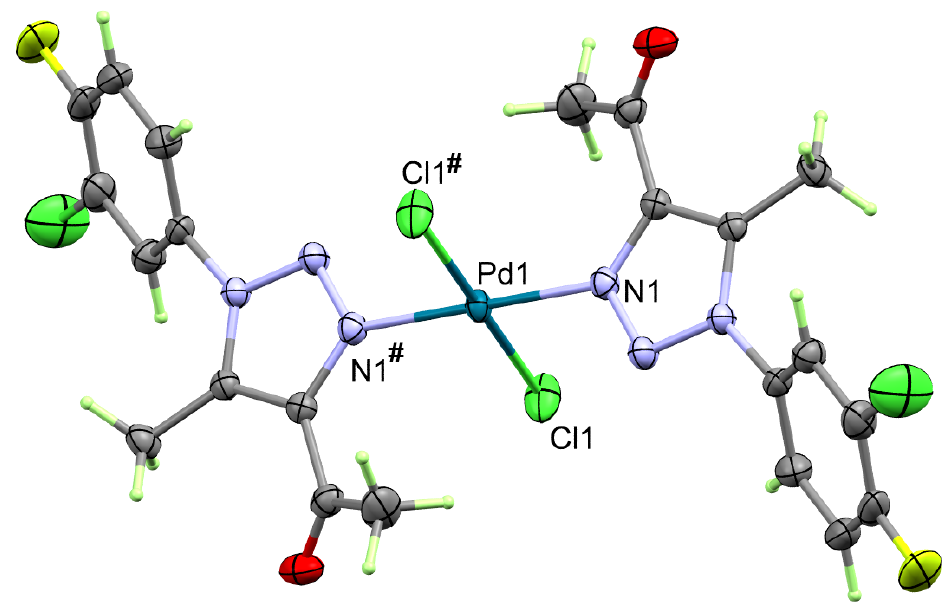
Figure 4. Structure of [Pd( 3 ) 2 Cl 2 ] complex 4 . Symmetry code: #1 − x + 1, −y, −z + 1. Table 4. Selected bond lengths [Å] and angles [°] for [Pd( 3 ) 2 Cl 2 ] complex 4 . Atoms Distance